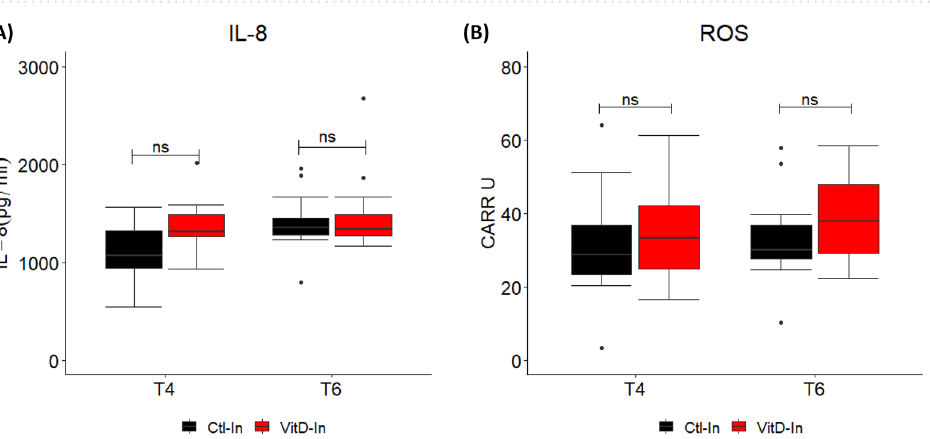
Figure 5. Serum concentration of IL-8 and ROS in calves from indoor groups. Data shows the boxplot of serum concentration of IL-8 and ROS at T4 and T6 in calves from Ctl-In (n = 11) and VitD-In (n = 12) groups . ( A ) IL-8 protein levels were measured by ELISA. ( B ) ROS were measured in serum using the d-ROM test. Data was analysed by ANOVA test. Dots represent outlier values. ns not